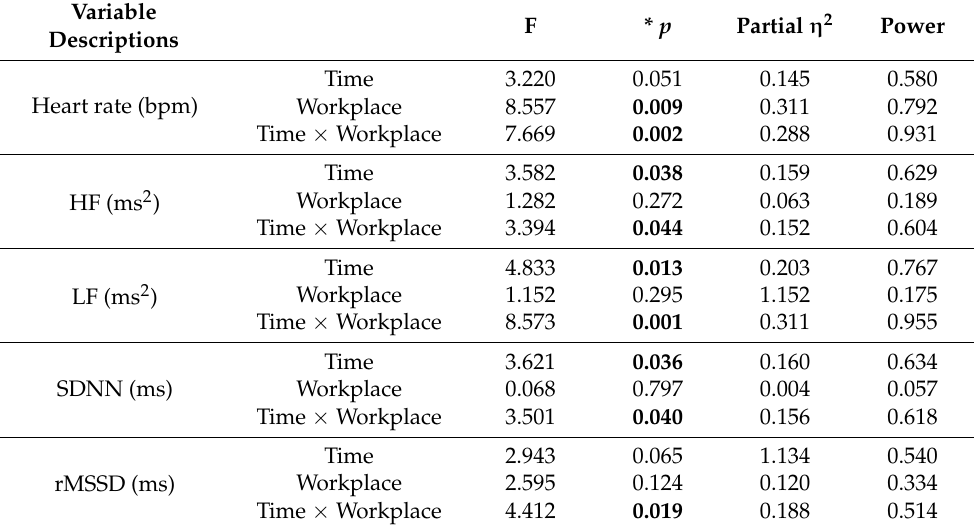
Table 2. The Workplace (telework; office) and Time (leisure time before workhours; work during regular workhours; leisure time after workhours) effects and interaction effect for heart rate and heart rate variability measures ( n =